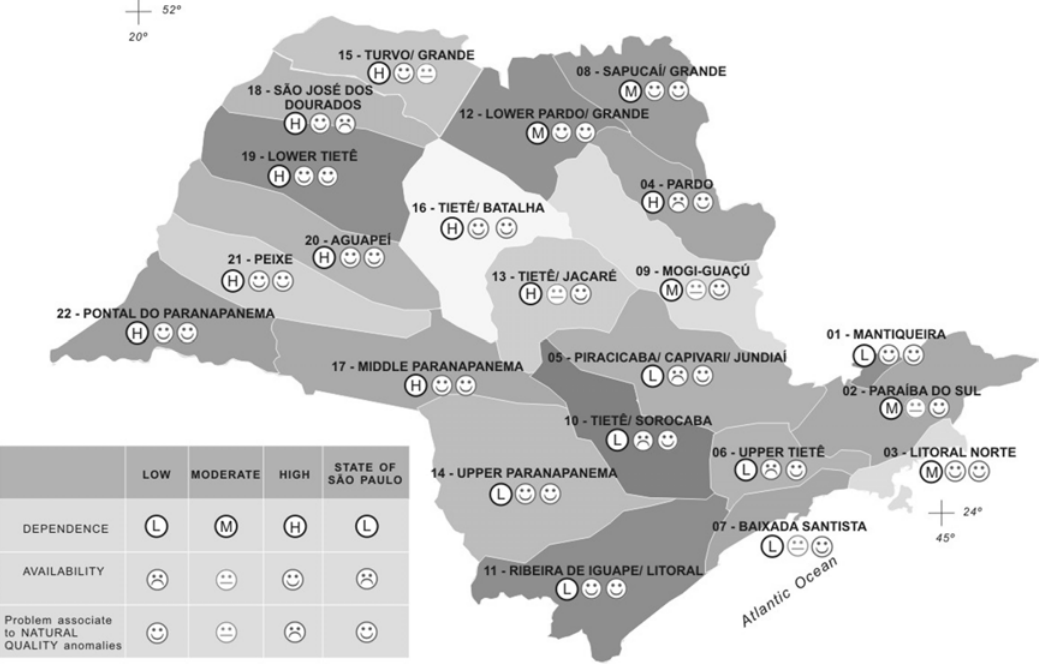
Fig. 3 – Example of material for public awareness using groundwater